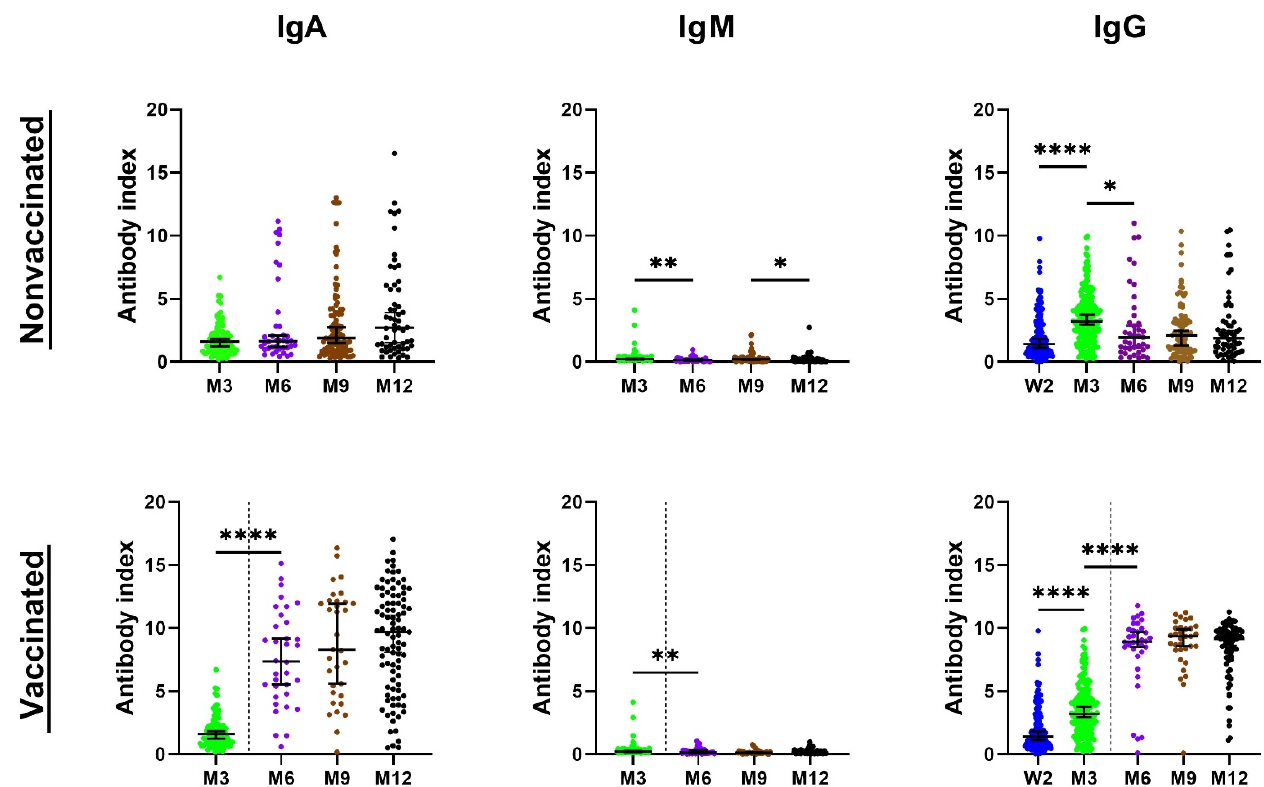
Figure 2. The detected antibody levels in the sera of cohort B over the 12-month period expressed as index values. Data are presented as the median ± 95% confidence intervals. The dotted line indicates the time when some patients started to be vaccinated. The nonparametric ANOVA Kruskal– Wallis post hoc Dunn’s multiple comparisons test was used for the statistical evaluation. Statistical significance is labeled as follows: **** p < 0.0001, ** p < 0.0075; * p <